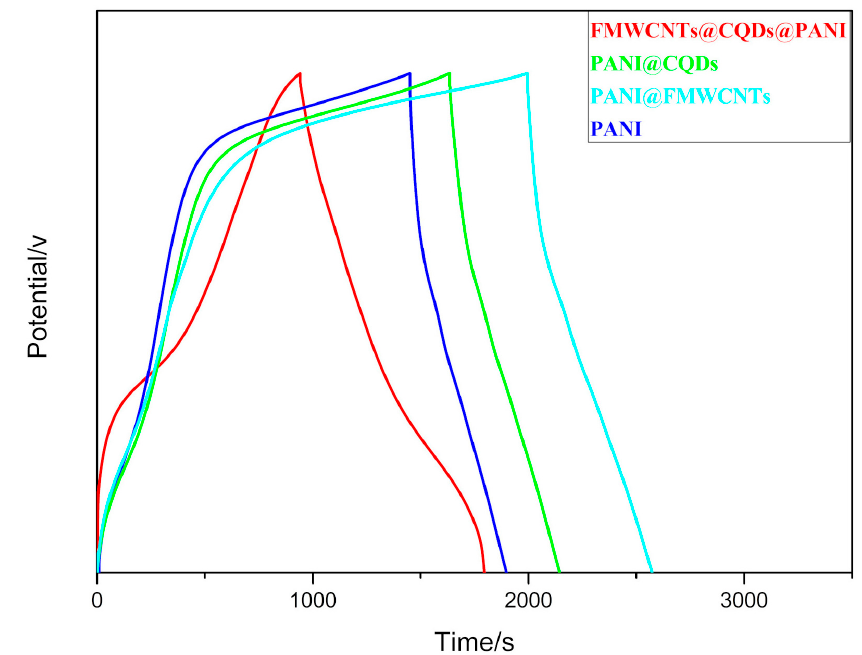
Figure 2. Constant current charge and discharge curves of PANI, PANI @ CQDs, PANI @ FMWCNTs and FMWCNTs @ CQDs @ PANI in 1 M H 2 SO 4 electrolyte.